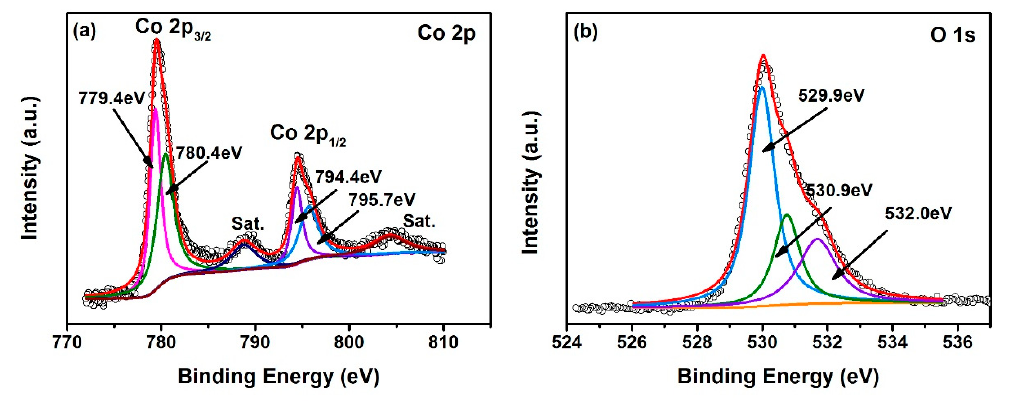
Figure 3. High-resolution X-ray photoelectron spectroscopy (XPS) scan of as-obtained Co 3 O 4 : ( a ) Co 2p region; ( b ) O 1s region.